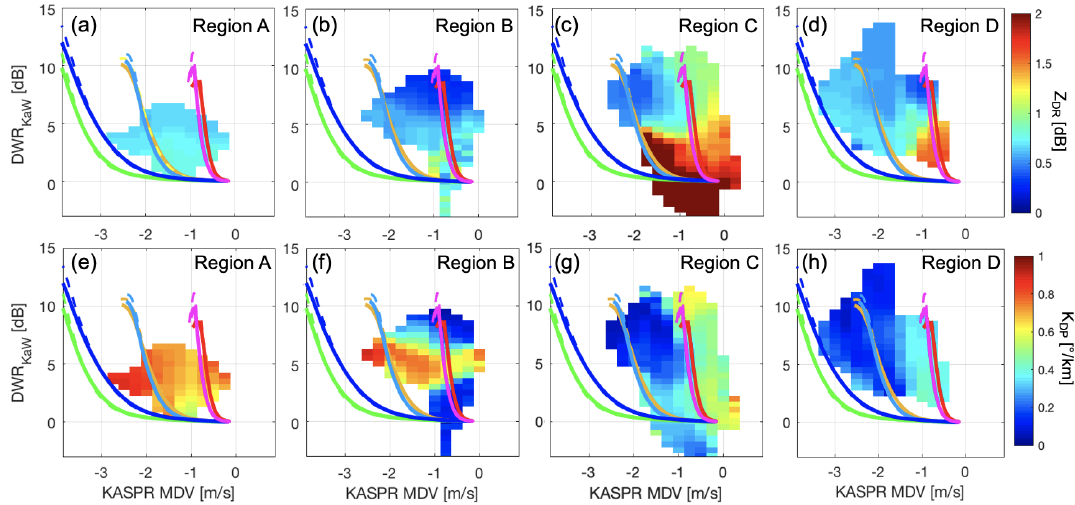
Figure 9. Diagrams of KASPR VPT MDV versus DWR KaW for (a, e) Region A, (b, f) Region B, (c, g) Region C, and (d, h) Region D. Color shades in (a) – (d) and (e) – (h) represent KASPR QVP Z DR and K DP , respectively, averaged at each MDV–DWR bin. Lines in each panel represent the SSRGA calculations using particle type and PSD models described in Appendix A. The legend for the lines is the same as in Fig.